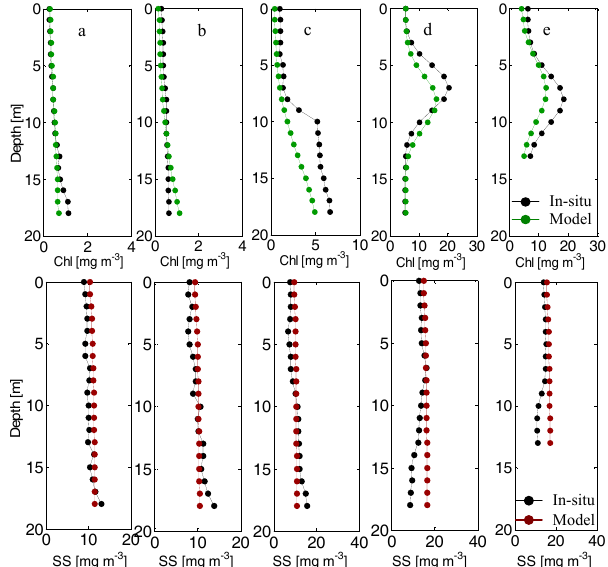
Figure 7. The examples of the modelled and measured vertical pro- files of [Chl( z )] for five different cases (top row). ( a and b ) St-1 and St-2 from relatively clear waters off Chennai, (c) St-4 from moder- ately turbid water with chlorophyll settled at the bottom of seabed. ( d and e ) St-6 and St-5 from the chlorophyll-dominated regions. The second row shows the modelled and measured vertical profiles of [SS( z )] for the same locations. The [SS( z )] modelled profiles are almost uniform along the